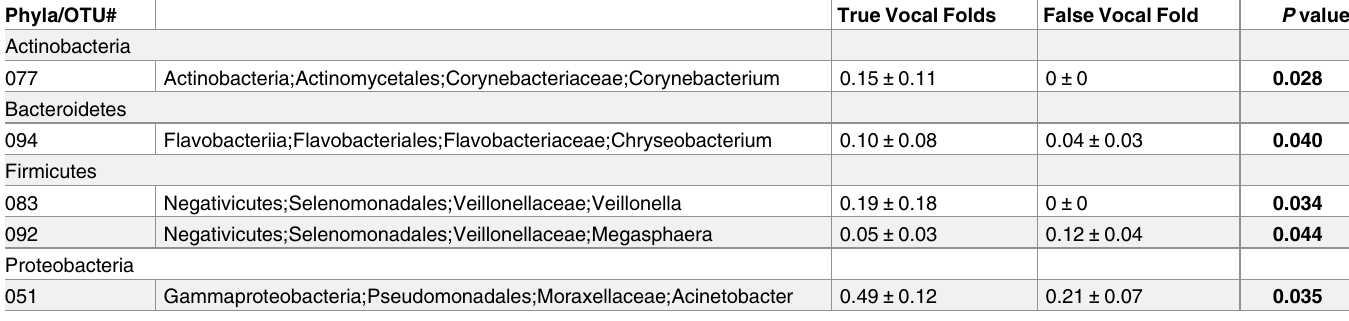
Table 3. OTUs identified by metastatsas significantly different between the true and false vocal